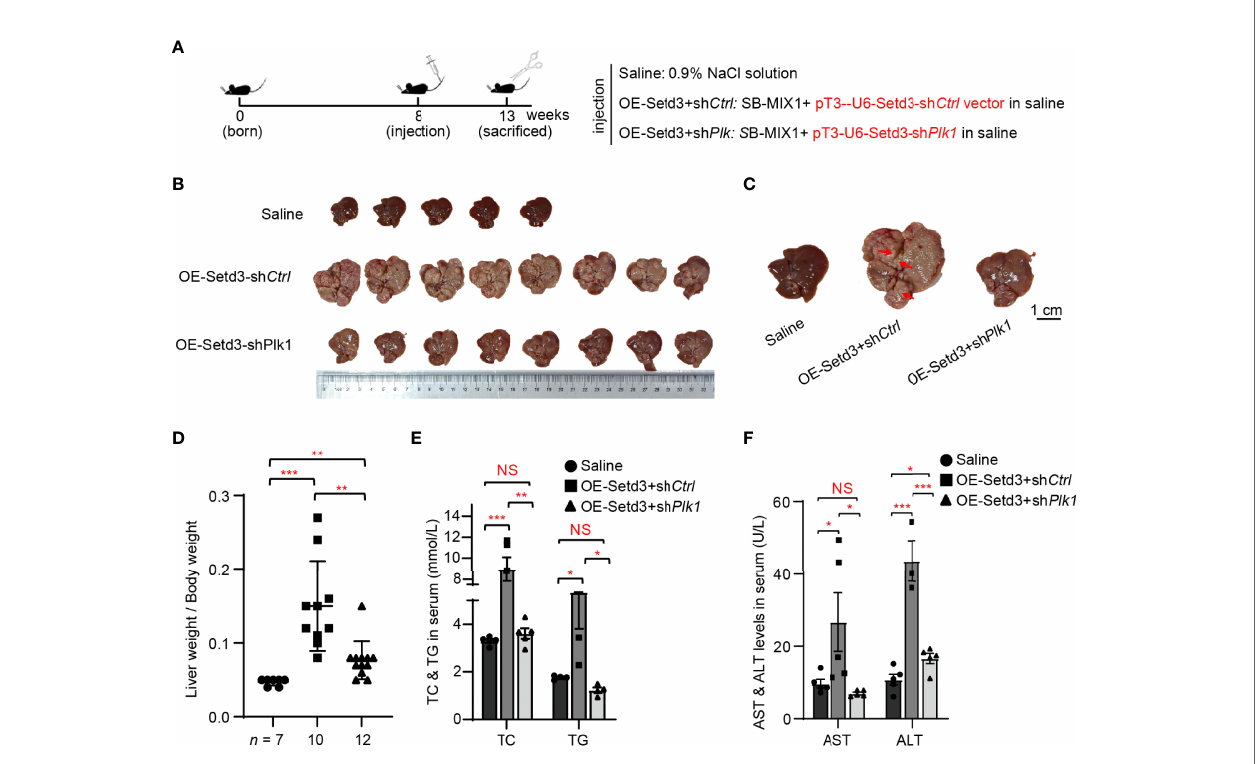
FIGURE 6 | Knockdown of Plk1 rescued Setd3 overexpression-induced hepatic tumorigenesis in mice. (A) Experimental procedure of development of hepatocarcinogenesis in mice by hydrodynamics-based DNA transfection. Each injection represents delivery of different components as indicated on the right. (B) Macroscopic appearance of livers and tumors from mice injected the indicated genes. Scale bar is shown below. (C) The representative enlarged images of livers from different mice are shown. The red arrows indicate the positions of liver tumors. Scale bar, 1 cm. (D) Relative ratios of liver weights vs. body weights in each group of hydrodynamic-injected mice ( n =7, 10, and 12 in saline, OE-Setd3+sh Ctrl , and OE-Setd3+sh Plk1 , respectively). (E, F) Quanti fi cation of serum TC and TG in panel (E) or serum AST and ALT in panel (F) of the indicated mice ( n = 5, per group). Data are presented as mean ± SD. NS, not signi fi cant; * p < 0.05; ** p < 0.01; *** p <